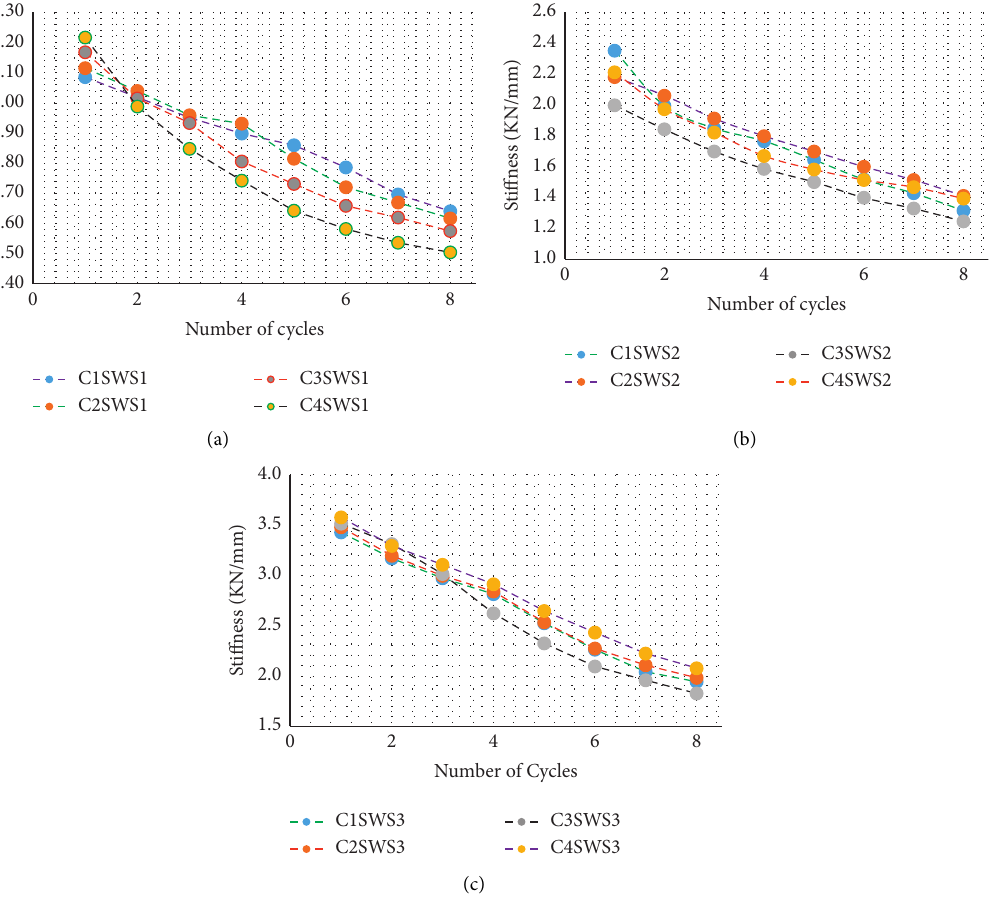
Figure 18: Effect of connection types on the stiffness degradation for aspect ratio ( t